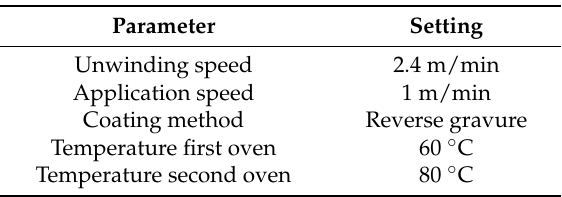
Figure 2. Schematic overview of a roll-to-roll coater. The foil is transported by multiple rolls, while deposition of the sol is achieved by a gravure roll. Before rewinding, a heat treatment takes place in the top ovens. Table 1. Coating settings for roll-to-roll coating.